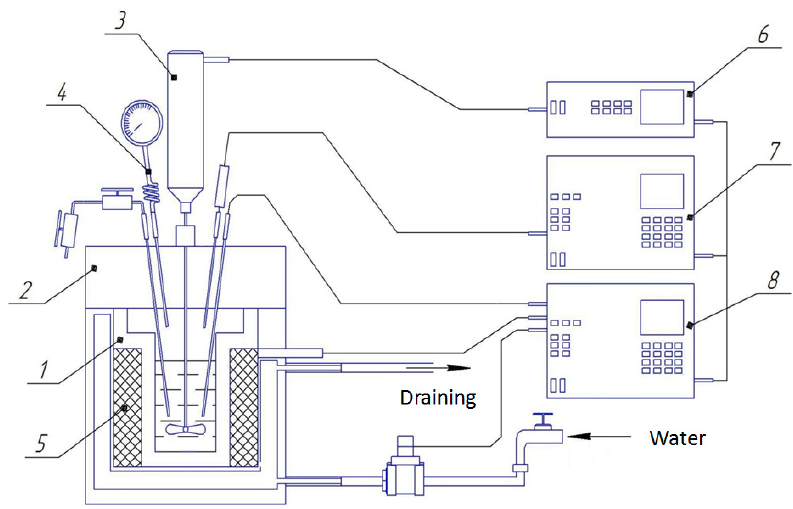
Figure 1. Diagram of the autoclave. 1: reactor; 2: reactor cover; 3: mixing device; 4: manometer; 5: electric furnace; 6: control unit for agitator; 7: pressure control unit; 8: temperature control unit.